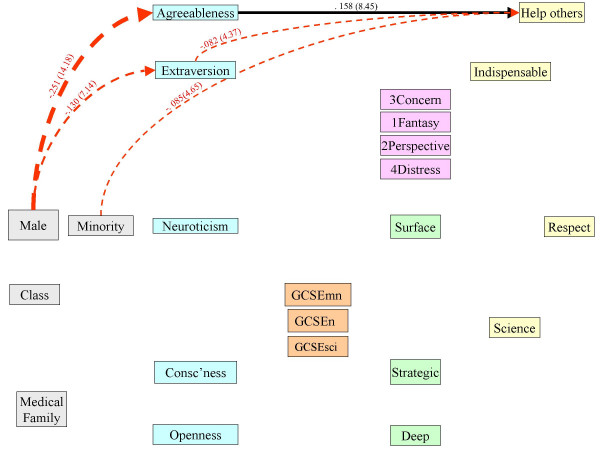
A reduced version of figure 1 in which the only paths shown are those with direct or indirect influences upon generic motivational factor 1 (Indispensability). All variable names have been left in the diagram, and are in the same positions as in figure 1.